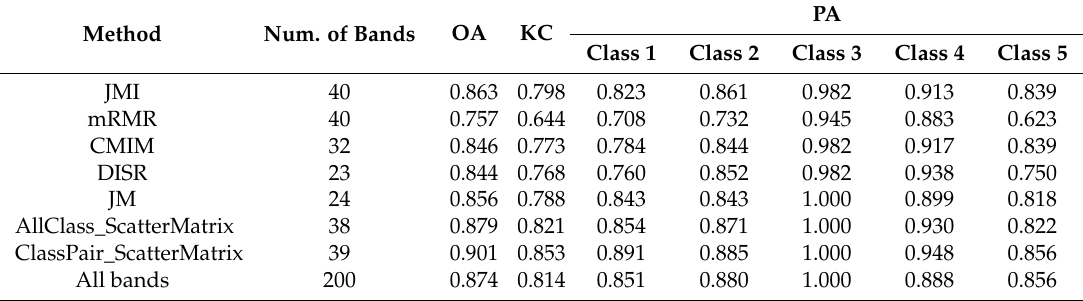
Table 2. Performance of the feature selection methods investigated in the paper on data set 2. PA: producer accuracy; OA: overall classification accuracy; KC: Kappa